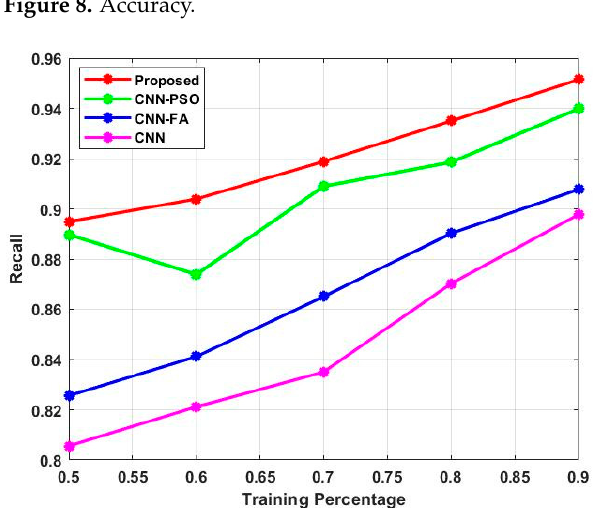
Figure 9. Recall. Figure 9.